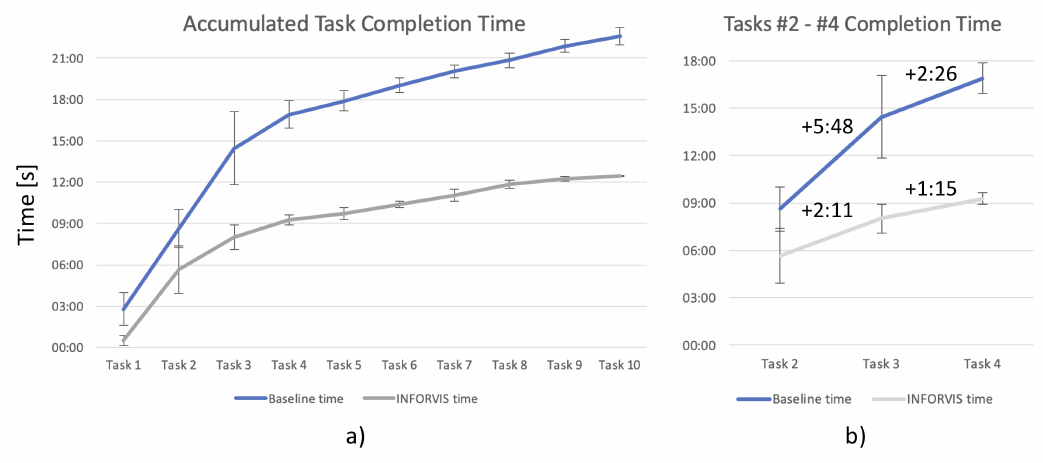
Figure 13. Task completion time diagrams for consecutive tasks throughout the study scenario. The upper dark blue line shows TCT with the baseline methodology. The lower grey line represents timings for the INFORVIS-based system. The vertical bars represent variation in the recorded timing results for all participants. ( a ) Accumulated TCT over the entire scenario for all the 10 tasks completed (left). ( b ) Segment of the three most demanding tasks: #2–#4 (right). The values presented above the segments of time plots indicate time increments for consecutive